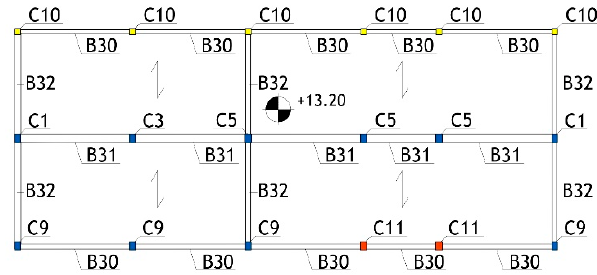
Figure 16. Localization of the interventions—third storey.